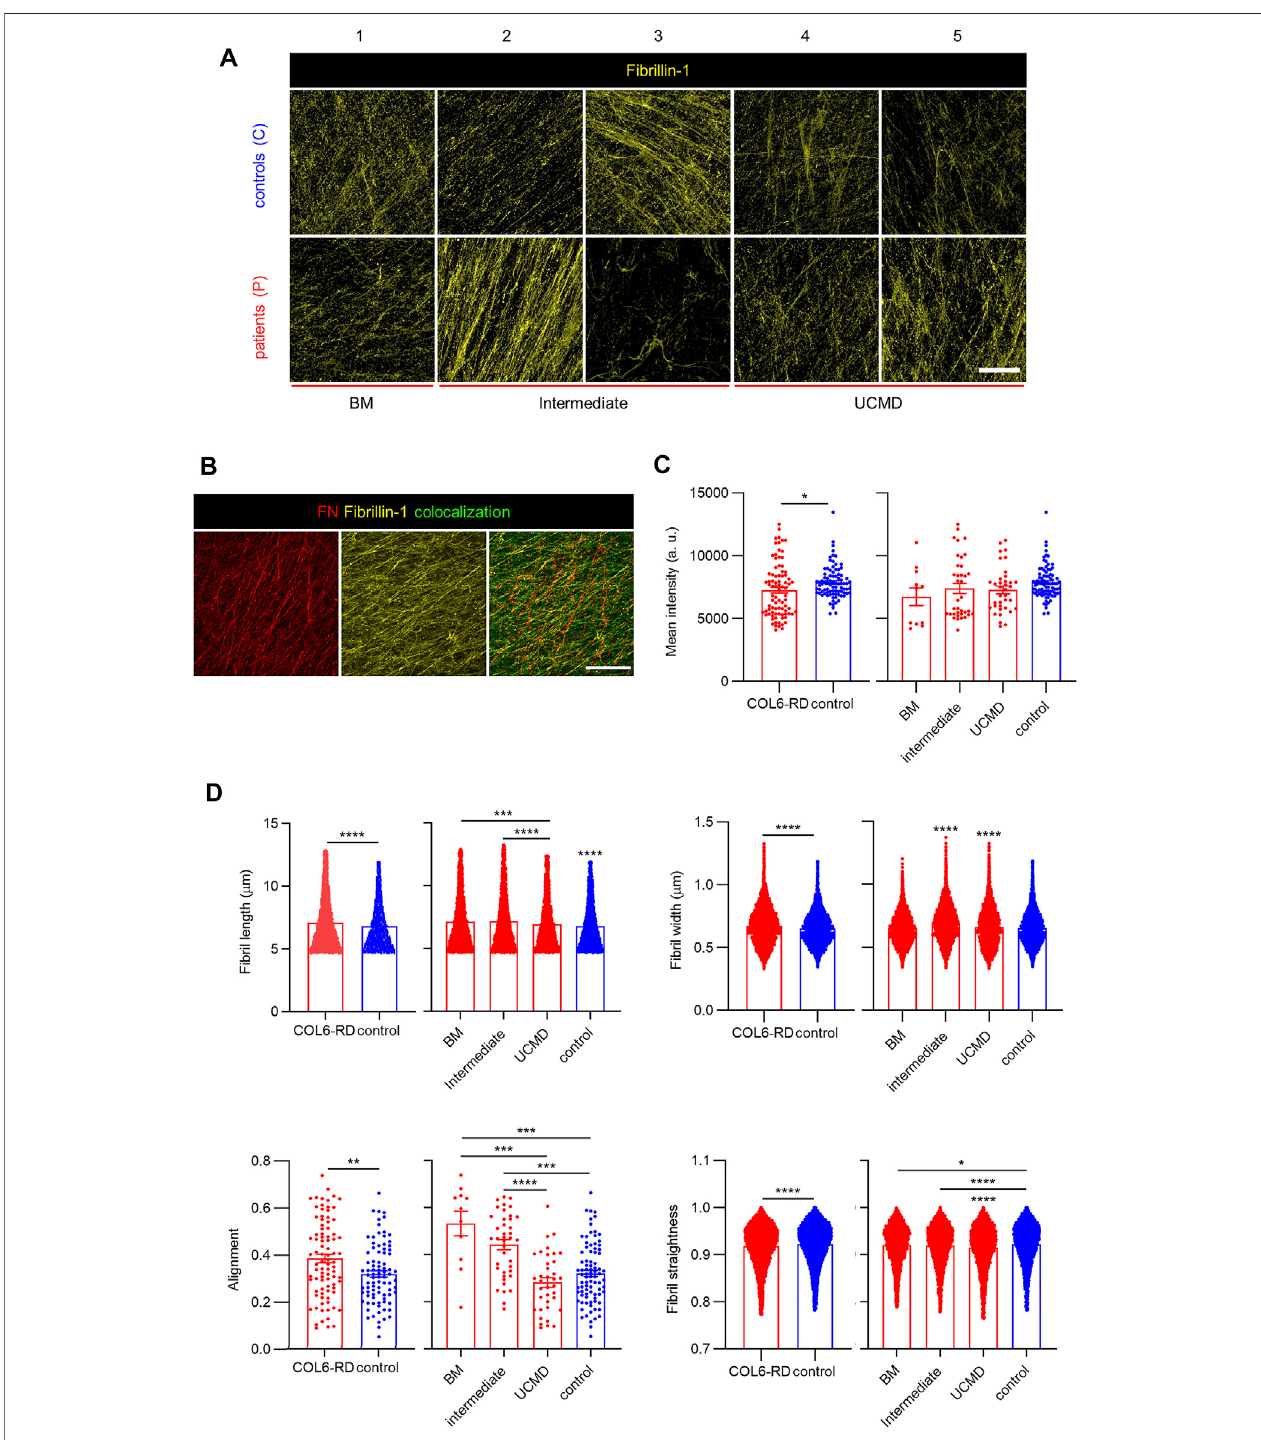
FIGURE 4 | FBN1 deposition in CDMs. (A) Representative confocal images of FBN1 immunostaining in CDMs from healthy donors (controls) and patients with COL6-RDs. FBN1 immunolabelling show distinct motifs of secretion. (B) Representative images showing the co-localization of FBN1 with FN fi brils. Scale bars: 50 µm. (C) Quanti fi cation of the mean fl uorescence intensity of FBN1 immunostaining. 11 ≥ n ≥ 86, showing its decrease for patients with COL6-RDs. (D) Quanti fi cation of FN fi bril length. 4964 ≥ n ≥ 46439, width. 5497 ≥ n ≥ 50922, alignment. 11 ≥ n ≥ 87, and straightness. 5345 ≥ n ≥ 49168 in CDMs through computational analysis. Three microscope fi elds of view were analyzed per replicate of at least 3 replicates per donor. Results are the mean ± SEM. * p < 0.05, ** p < 0.01, *** p < 0.001, **** p < 0.0001.